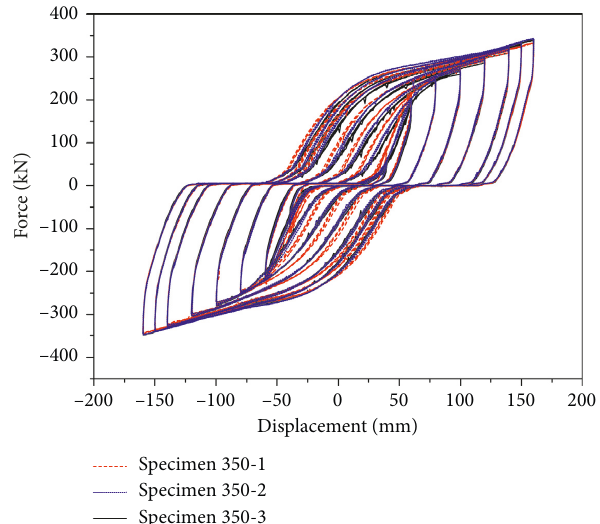
Figure 11: Force-displacement hysteresis curve of the three specimens.